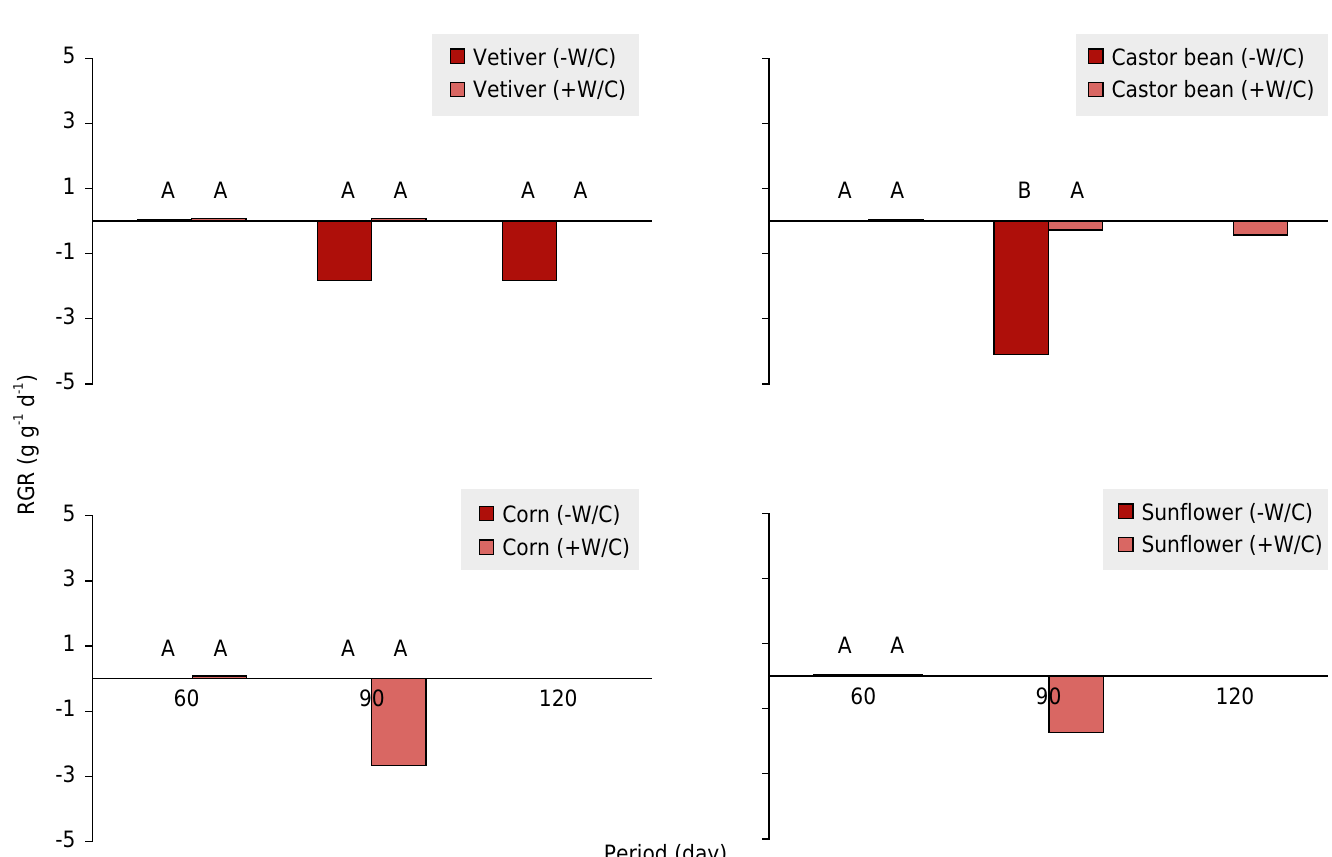
Figure 1. Relative growth rate (RGR) in vetiver, castor bean, corn, and sunflower plants conducted in soil contaminated with lead, without (-W/C) and with (+W/C) correction of soil pH, at 60, 90, and 120 days after planting (DAP). Means followed by the same letter, within each period, do not differ among